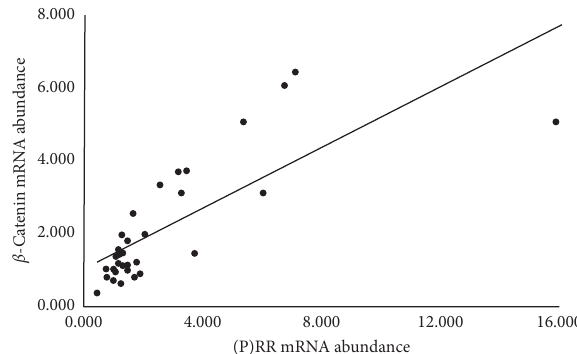
Figure 2: Scatter plots showing the positive association between adrenal (P)RR and β -catenin mRNA abundance. (P)RR: (pro)renin